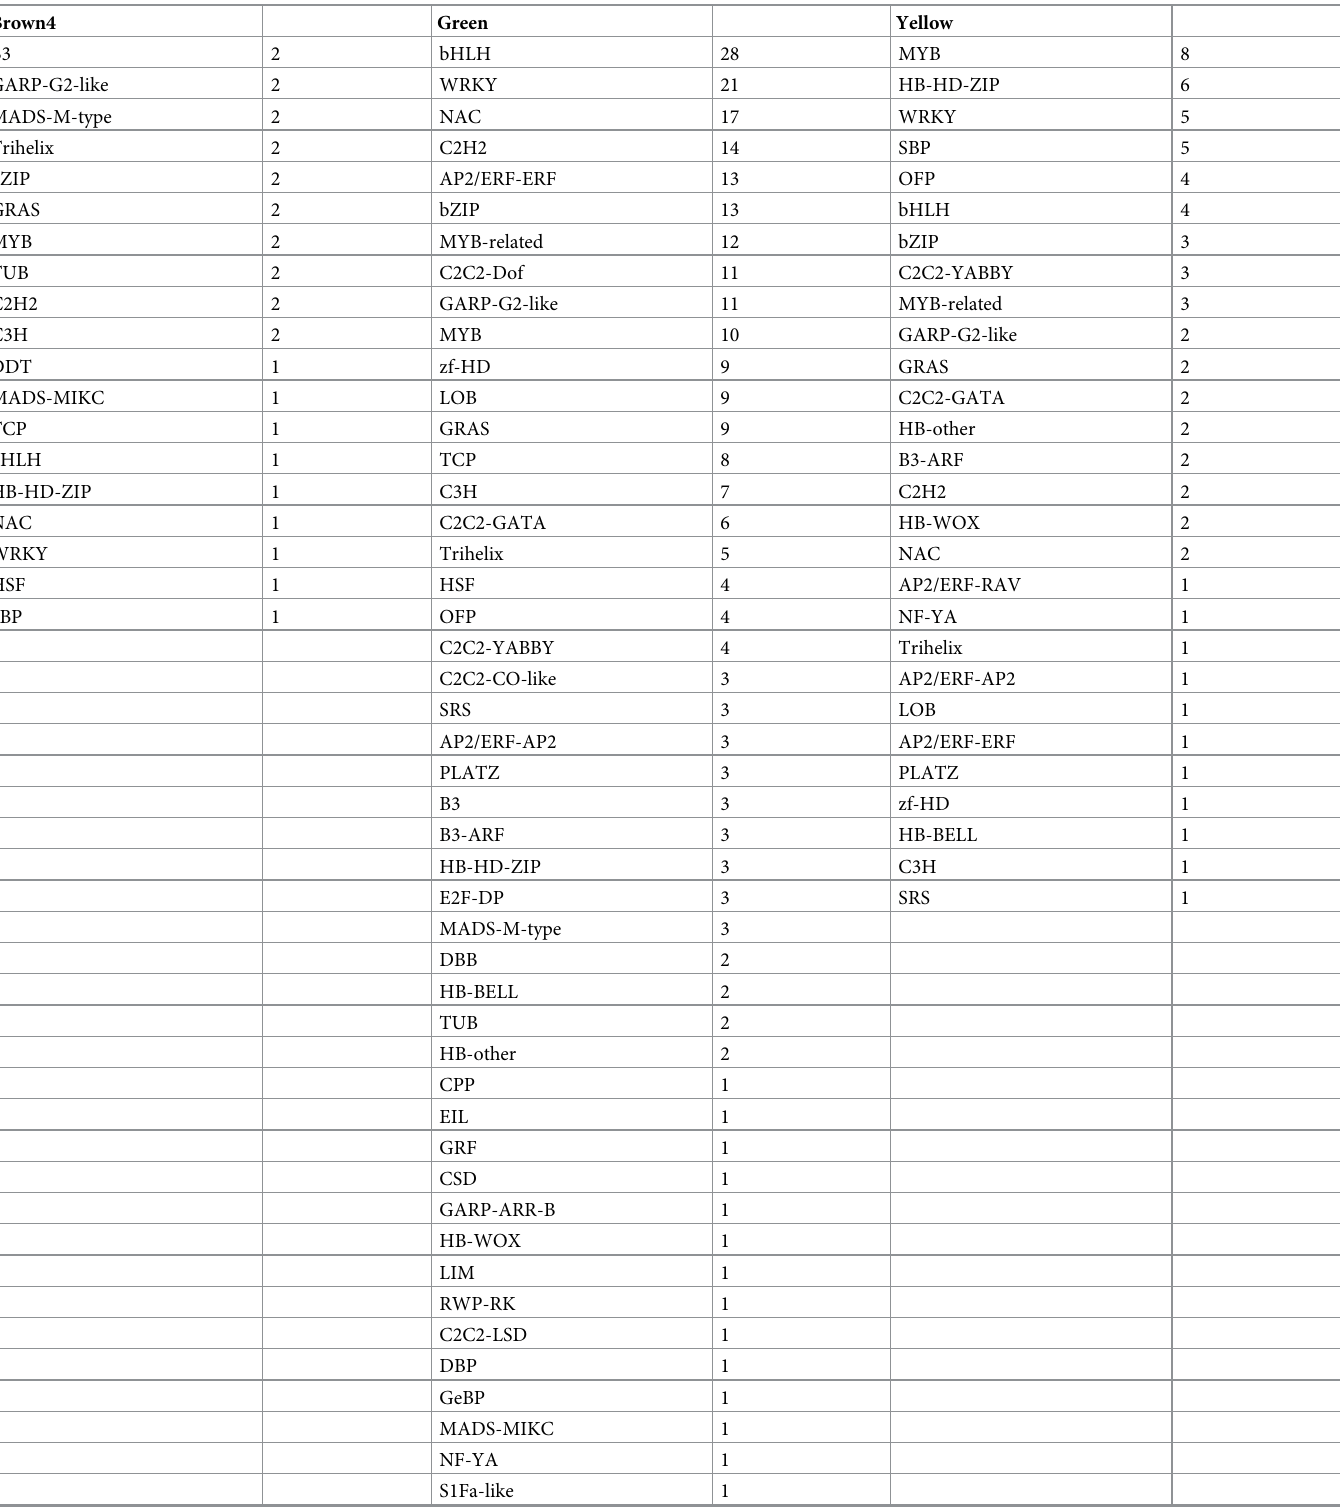
Table 4. TF families in the selected modules.